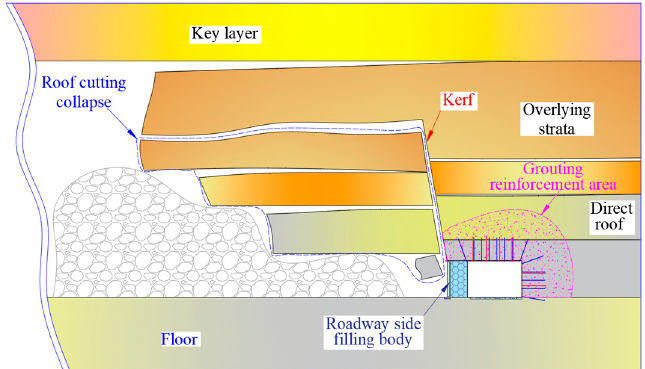
Figure 20. Deformation statistics of surrounding rocks of the roadway. Roof cutting is located at the side of the working face. The roof-cutting height and angle are set to 15.3 m and 10°, respectively. Meanwhile, the grouting reinforcement is adopted for the roof and side coal pillars of the gob-side entry-retaining technology. Jin’an Reinforcement I # is selected as the grouting material by deep-shallow hole grouting, with depths of 5 and 2 m, respectively.